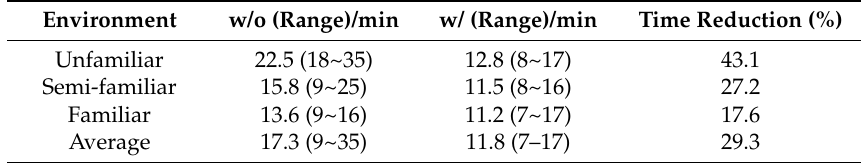
Table 6. Intention to